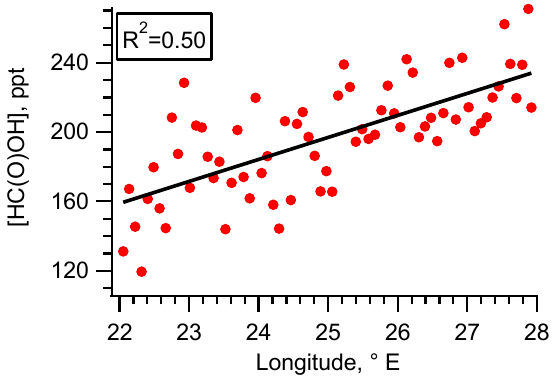
Figure 4. Represents the concentration change in HC(O)OH as the aircraft travelled east along transect x during flight B796b on 16 August 2013.